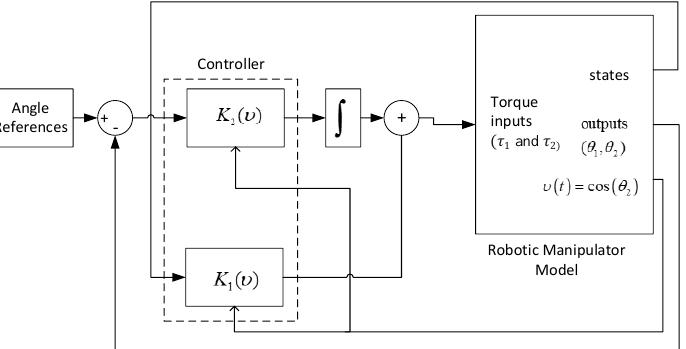
Figure 2. Control system